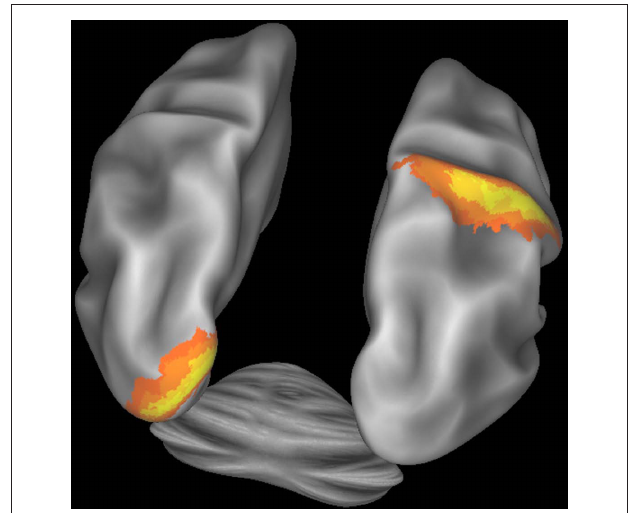
FIguRe 5 | Connectome Workbench visualization of the inflated atlas surfaces for the left and right cerebral hemispheres plus the cerebellum. Probabilistic architectonic maps are shown of area 18 on the left hemisphere and area 2 on the